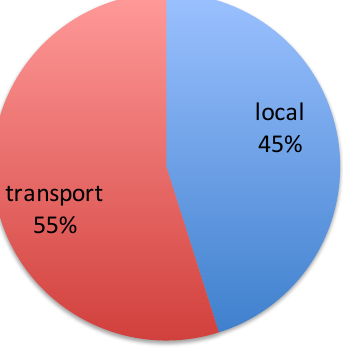
Figure 10. Contribution made by net transport and local effects to PM 2 . 5 increases in BJ, 6–7 December 2013.